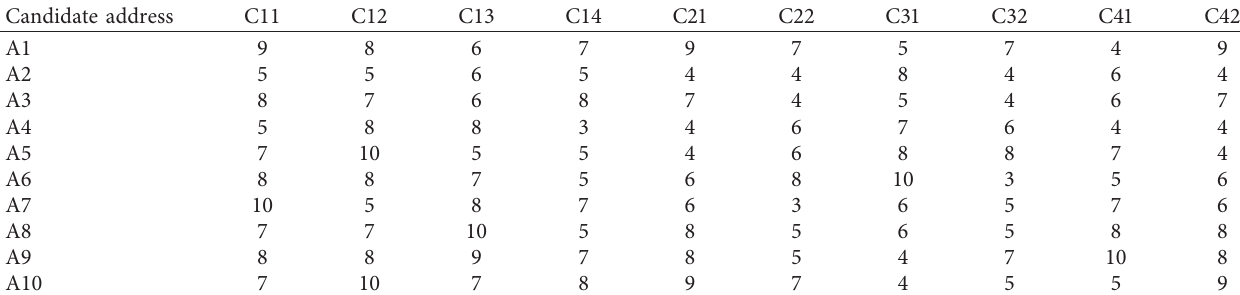
Table 1: Correspondence table of index evaluation values.